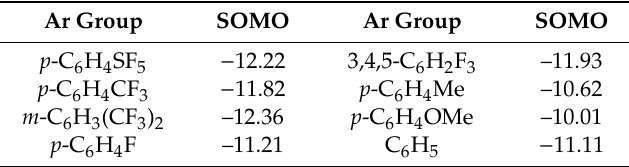
(CAM-B3LYP / 6-311G(d,p)).